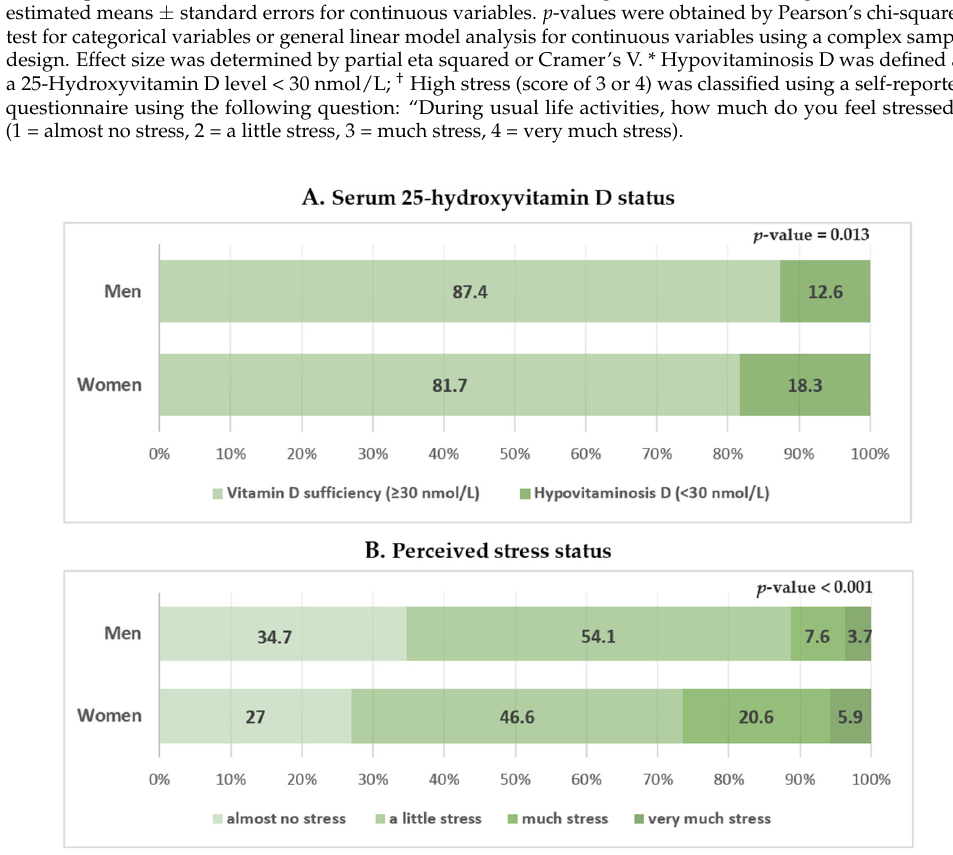
Figure 2. Serum 25 ‐ hydroxyvitamin D level and perceived stress status according to sex.